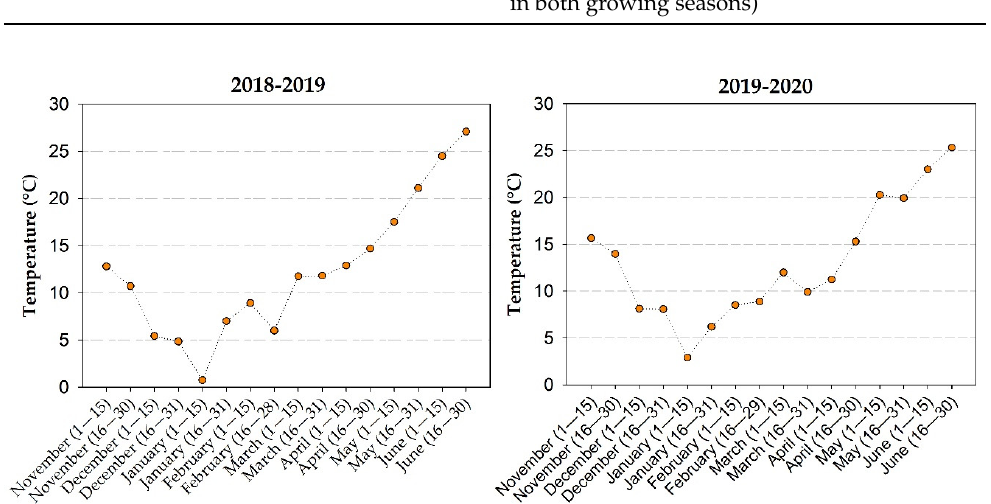
Figure 1. Mean air temperature (°C) during the growing period in 2018/19 ( left ) and 2019/20 ( right